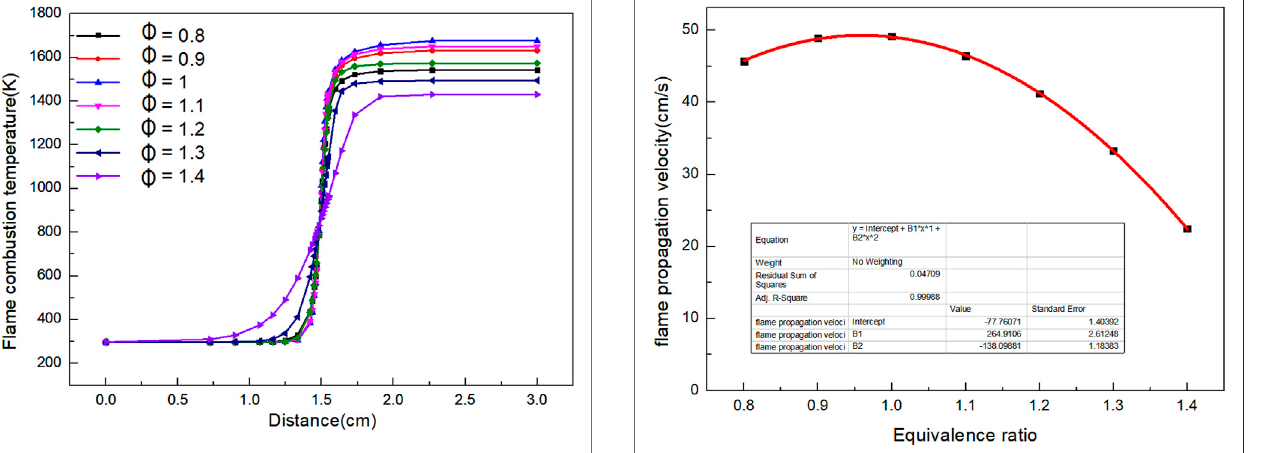
fl ame velocity versus Φ